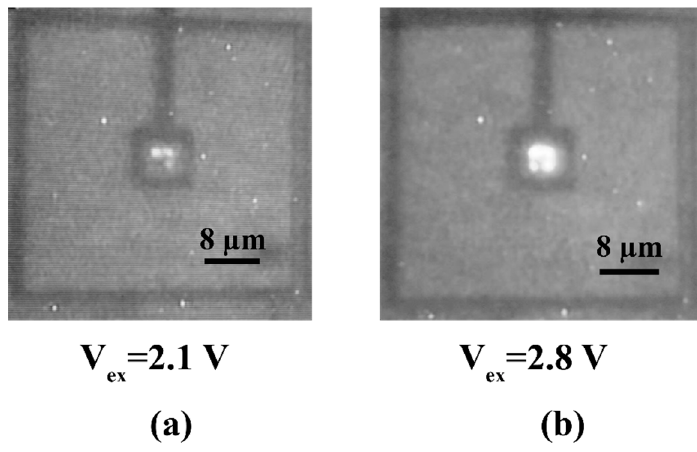
Figure 6. Photomicrograph of the CASPAD device emitting light at ( a ) V ex = 2.1 V and ( b ) V ex = 2.8 V.